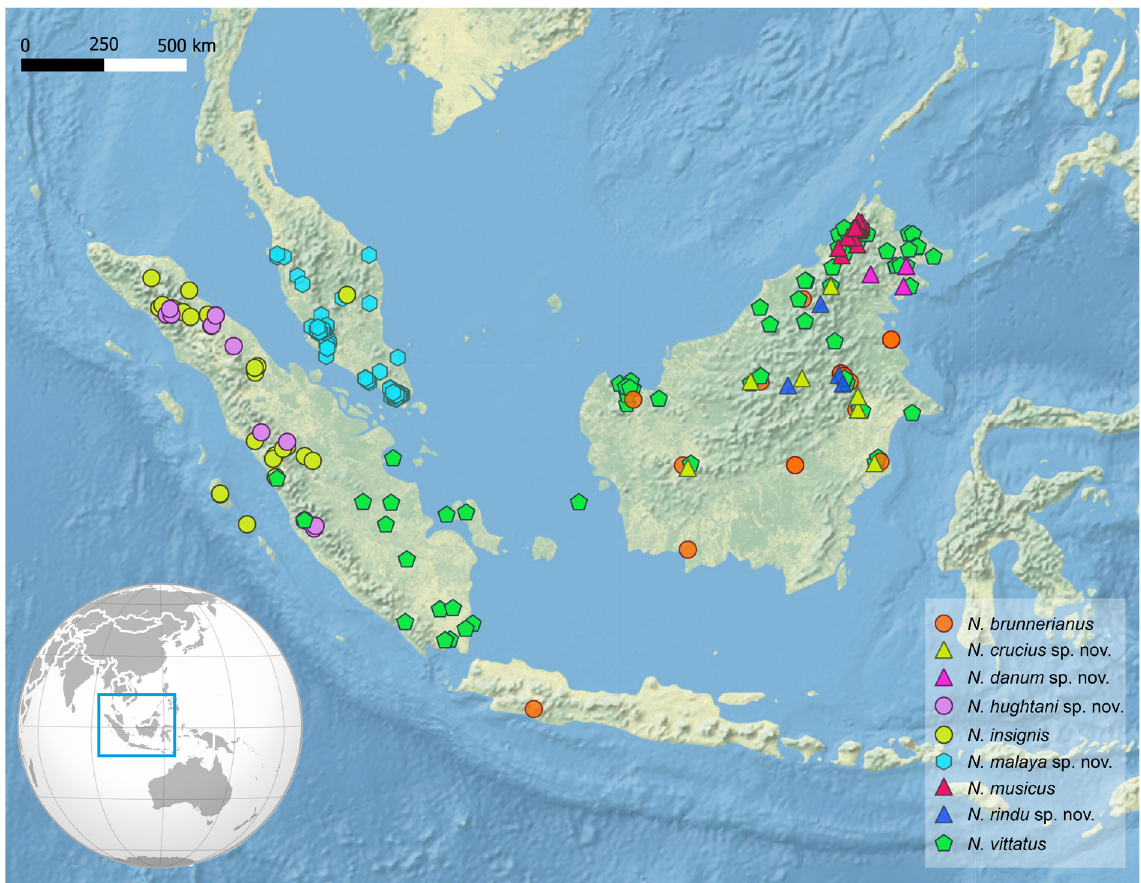
Fig. 5. Map of Southeast Asia showing the distribution of species of Nisitrus Saussure, 1878. Each coloured symbol represents one sampling or observation locality listed in the material in the